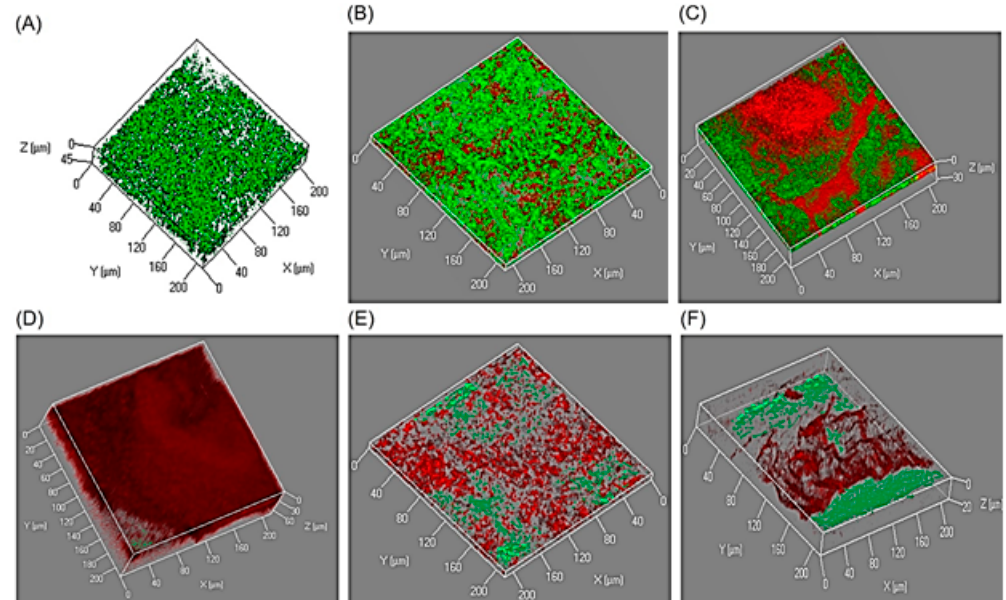
Figure 5. Antibiofilm activity of CHI ‒ AgNPs conjugates against Pseudomonas aeruginosa : ( A ) control, ( B ) CHI ‒ AgNPs1, ( C ) CHI ‒ AgNPs2, ( D ) CHI ‒ AgNPs3, ( E ) CHI ‒ AgNPs4, and ( F ) CHI ‒ AgNPs5.